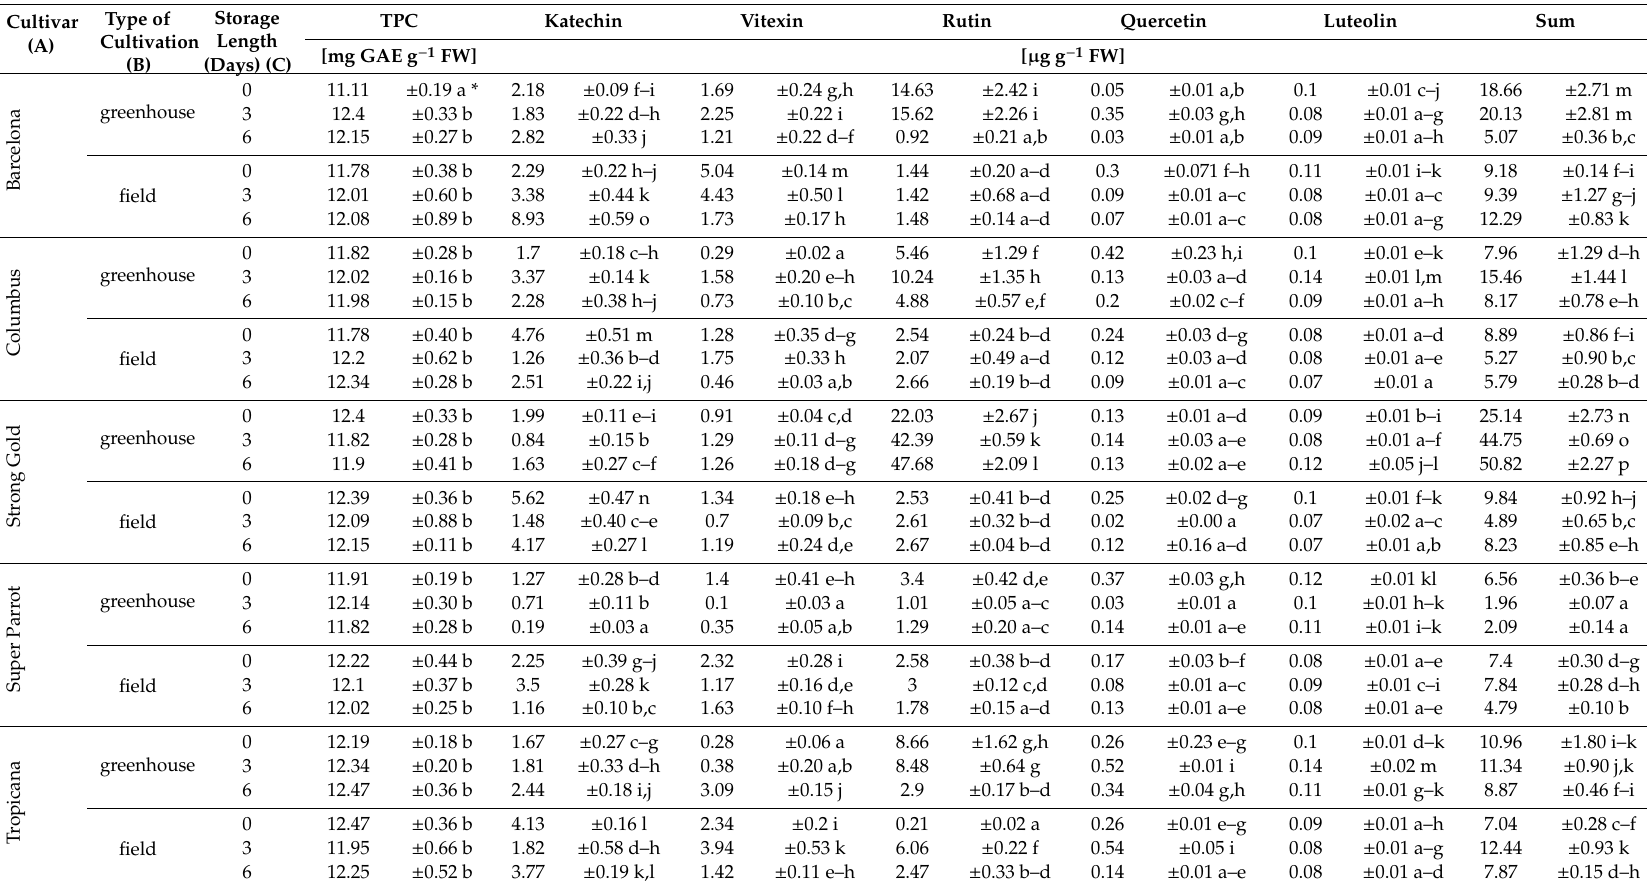
Table 1. Profiling of tulip flower